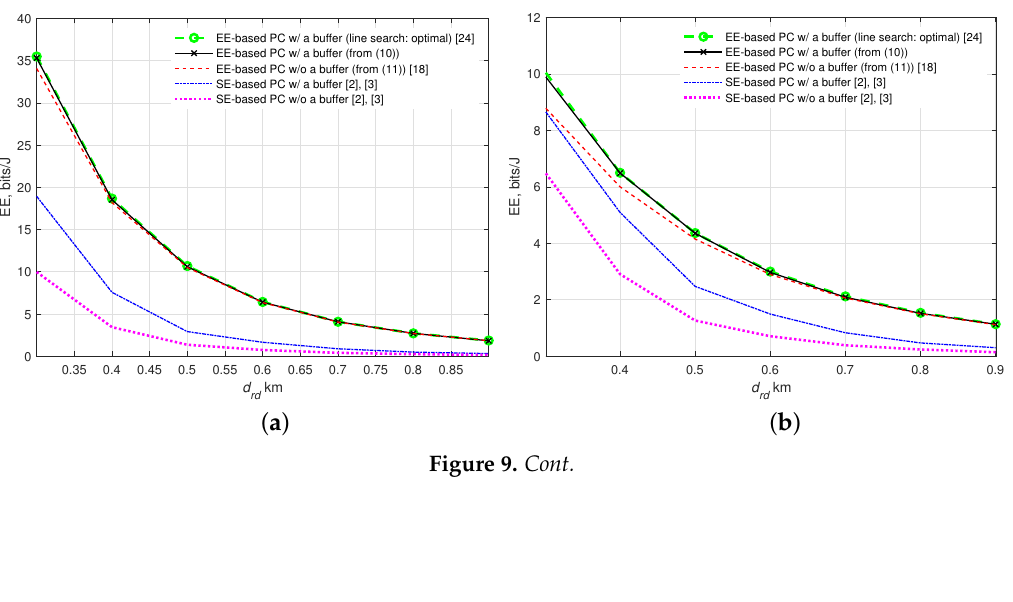
Figure 8. EE across P c with EE- and SE-based power control (PC) for RN. ( a ) d rd = 0.3 km. ( b ) d rd = 0.5 km. ( c ) d rd = 0.7 km. ( d ) d rd = 0.9 km.